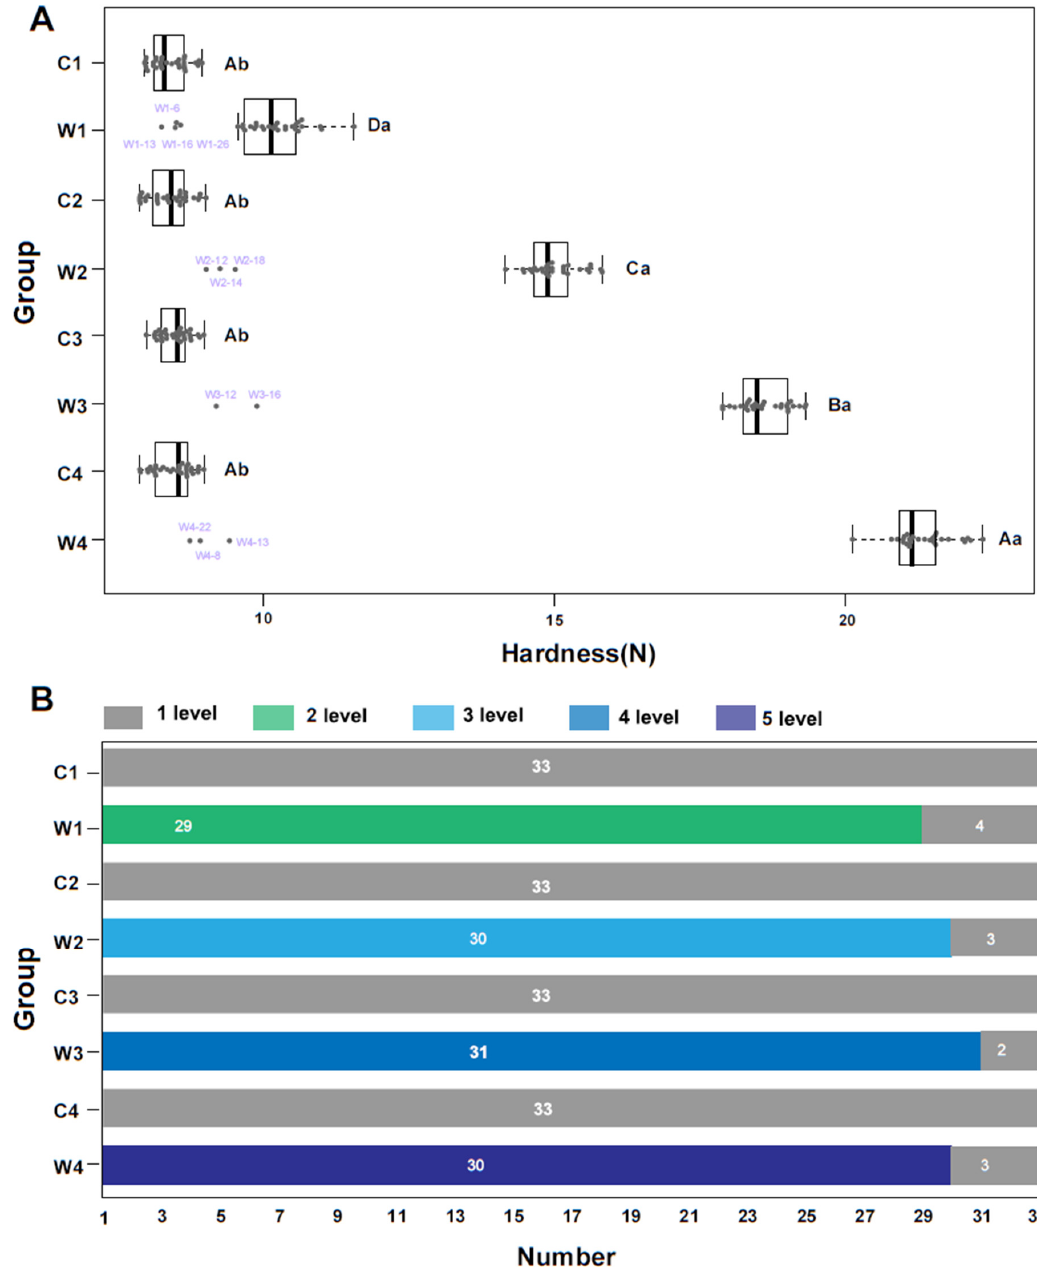
Figure 1. Removal of outliers using muscle hardness. C1, C2, C3, and C4 represent the ordinary grass carp from 30, 60, 90, and 120 day, respectively. W1, W2, W3, and W4 represent the crisp grass carp from 30, 60, 90, and 120 day, respectively. ( A ) Boxplot of muscle hardness of crisp grass carp and ordinary grass carp during different farming stages. Boxes represent the interquartile range, and whiskers delineate ± 1.5 times the interquartile range beyond the box boundaries. Points falling outside of the whiskers were considered outliers in this study. Statistical analyses were performed using Student’s t -test and Duncan’s test. Different lowercase letters represent significant differences in muscle hardness ( p < 0.05). Different uppercase letters represent significant differences in muscle hardness ( p < 0.05). ( B ) Sensory texture evaluation of crisp grass carp and ordinary grass carp during different farming stages. Samples from 33 fish were evaluated for each group.